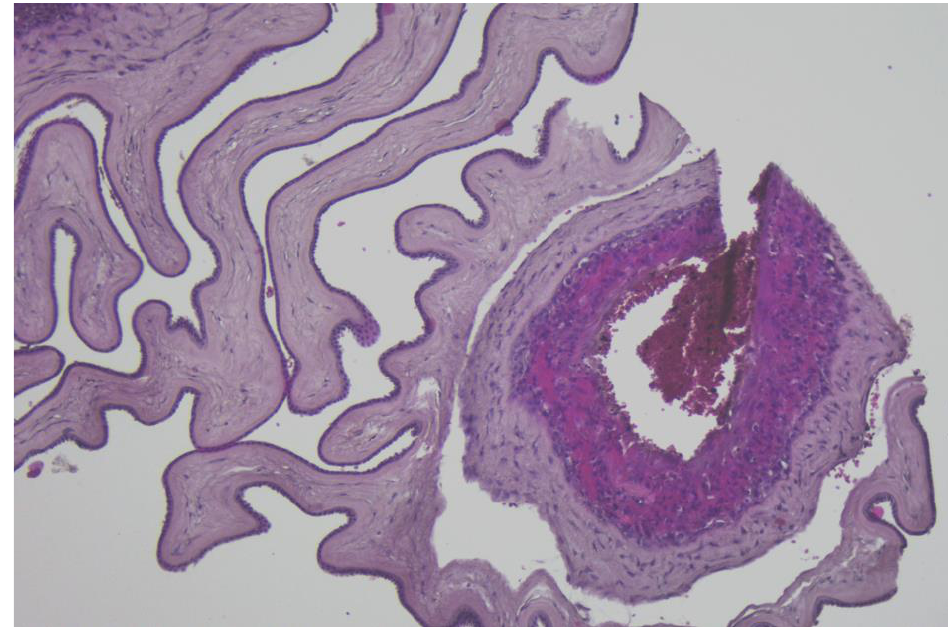
Figure 3. Amniotic membrane section, without inflammatory cells, H&E stain, ×100 magnification.